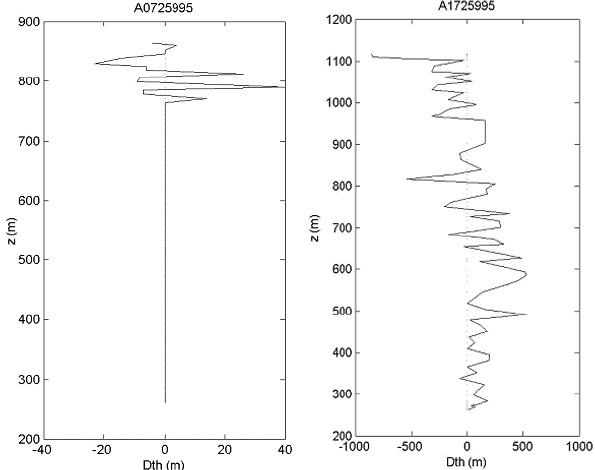
Figure 1. Left curve: Thorpe displacement D th profile with an iso- lated patch corresponding to 07:00GMT. Right curve: Thorpe dis- placement D th profile with a random mix of fluctuations corre- sponding to 17:00GMT.